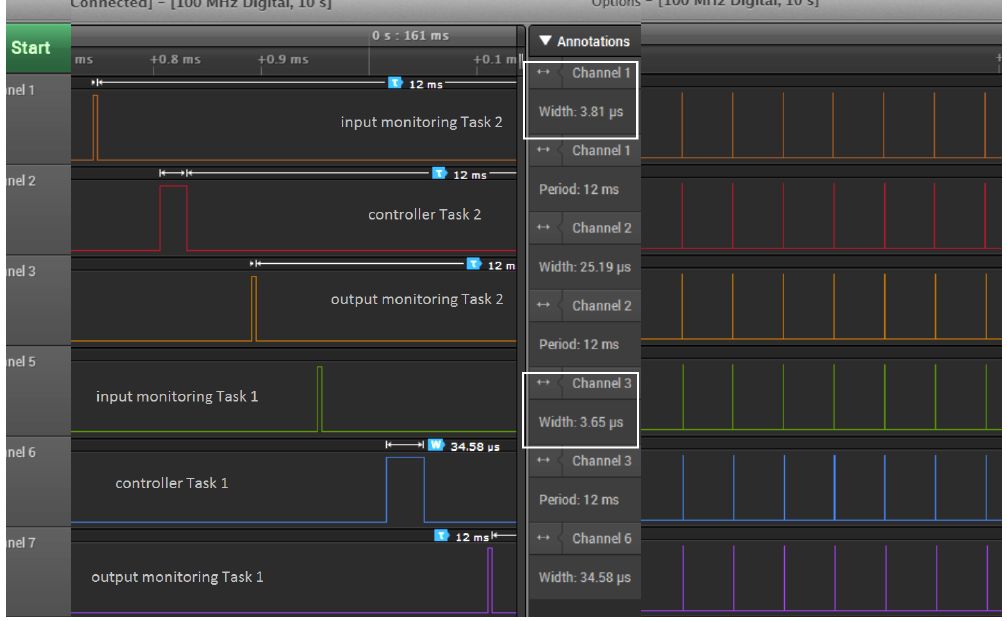
Figure 13. The input and output monitoring task activations for two controller tasks captured using a logic analyzer. Both the controller tasks Task 1, Task 2 are activated with a period of 12 ms. Both are different control algorithms which run for an execution time of 34.58 µ s and 25.19 µ s, respectively at the highlighted job instant. The monitoring tasks execute only a fraction of the controller’s computation time, typically less than 4 µ